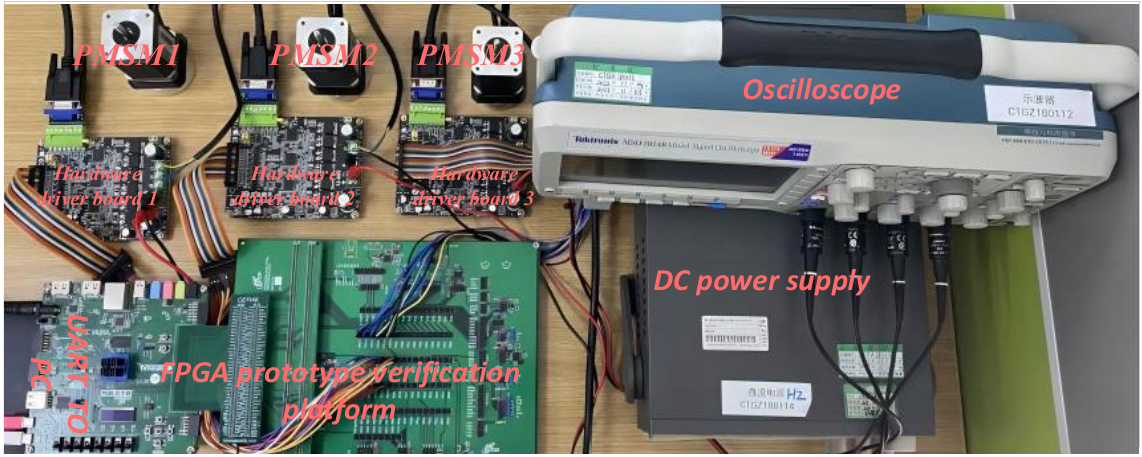
Figure 16. Diagram of the experimental platform.